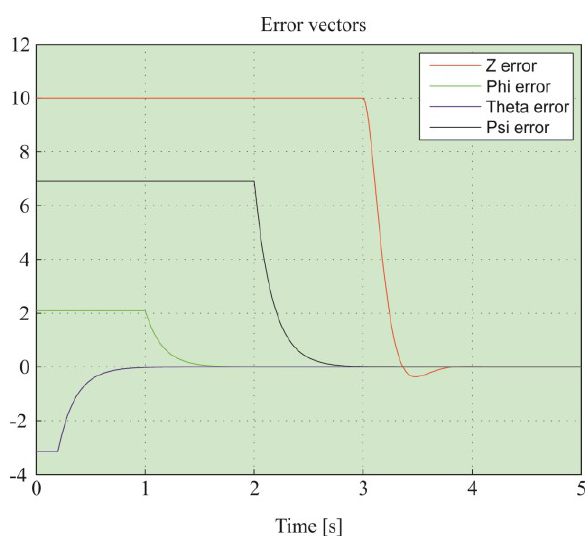
Fig. 6. Errors in platform control (start- stabilization of the flight)